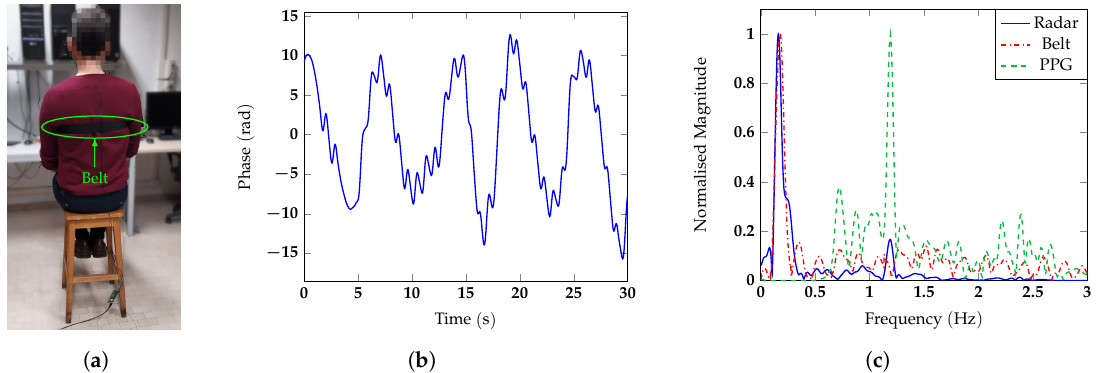
Figure 9. ( a ) Photo of the experimental setup in which the back of the subject is facing the antenna; ( b ) vital signs extracted by the radar in the time domain and ( c ) spectrum.